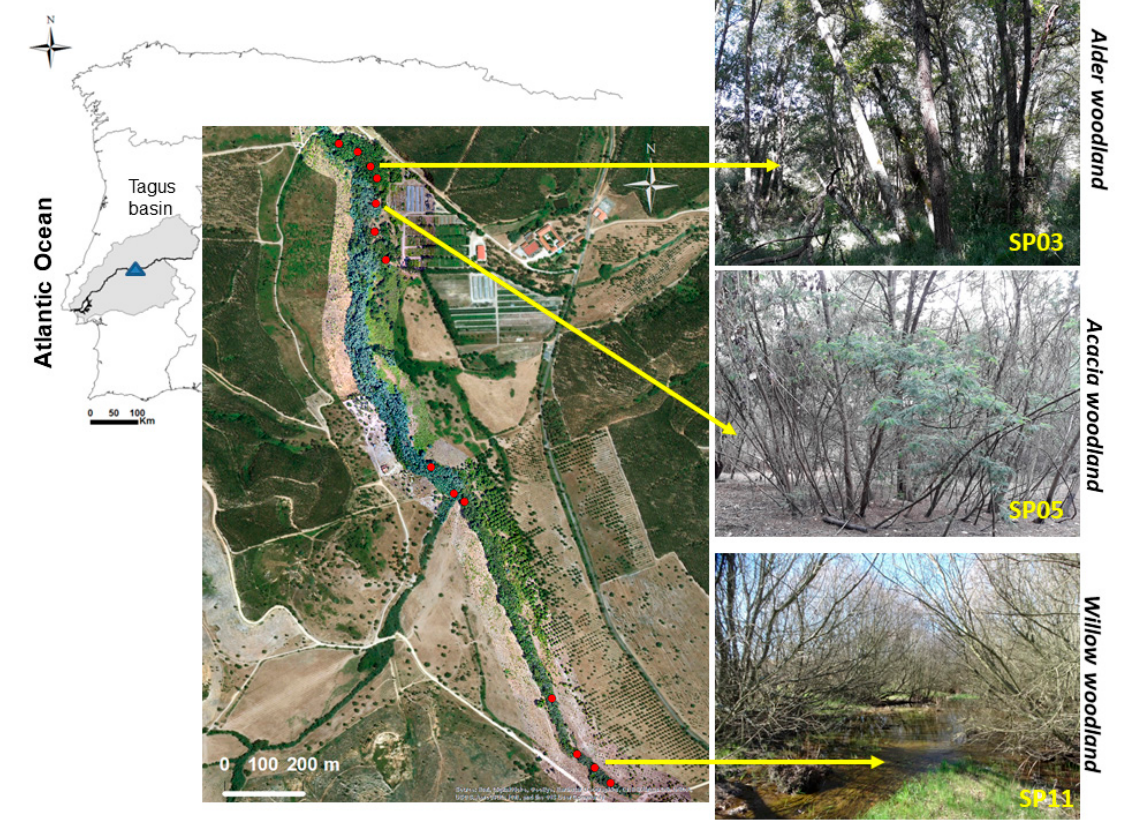
Figure 1. Map of Western Europe showing the Portuguese part of the Tagus basin (grey area) and the location of the study area (blue triangle) in Tagus river (black line). The middle panel shows the location of the 15 circular sampling plots (SP) (red dots) in the studied river zone. Vertical composite panel shows an example of the alder, acacia, and willow woodlands in the SP03, SP05 and SP11, respectively.